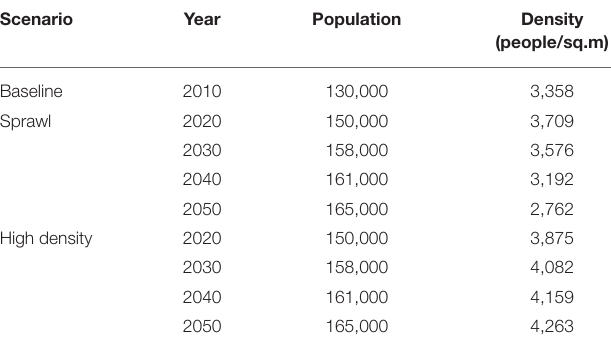
TABLE 1 | Estimated population and population density of the city of Fort Collins.